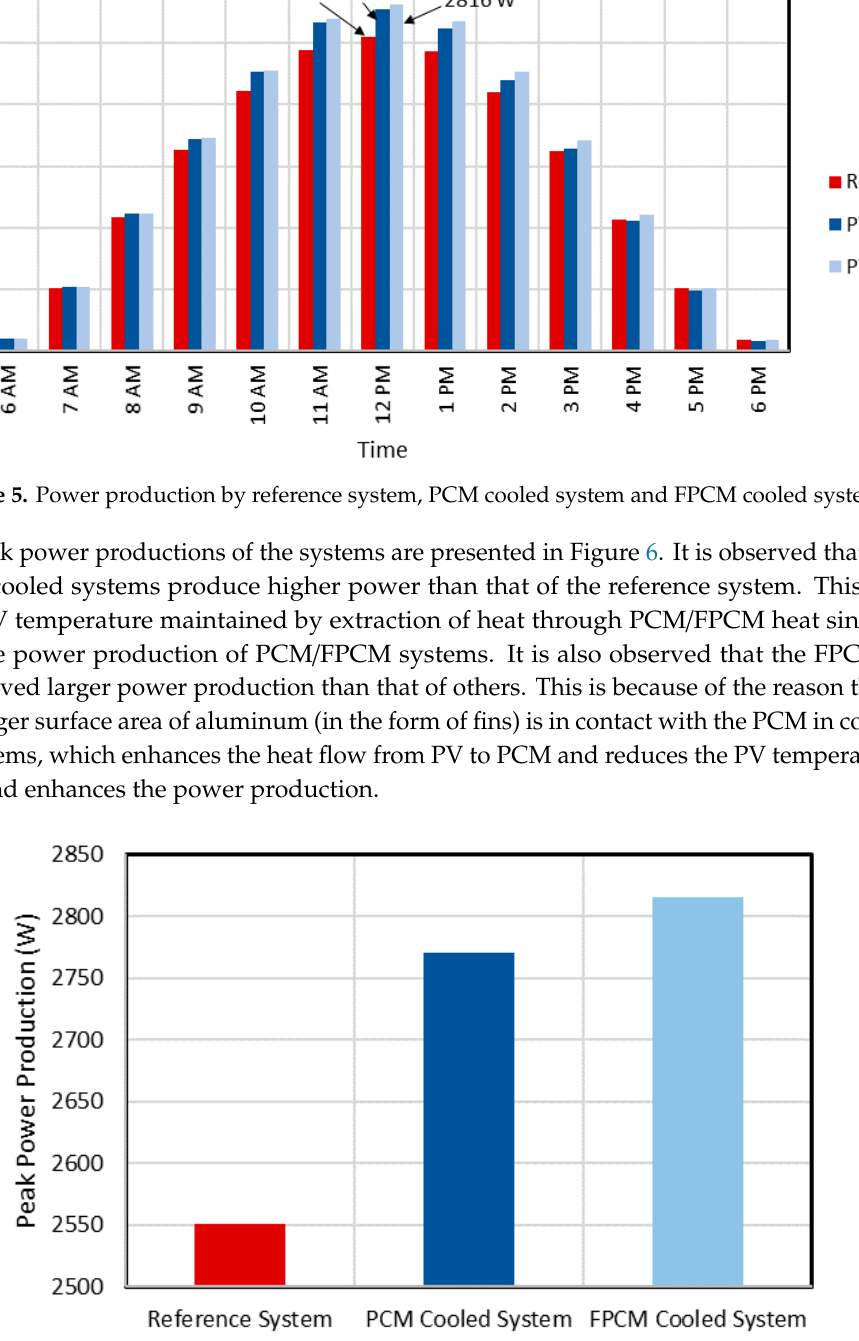
Figure 6. Peak power production by reference system, PCM cooled and FPCM cooled systems.